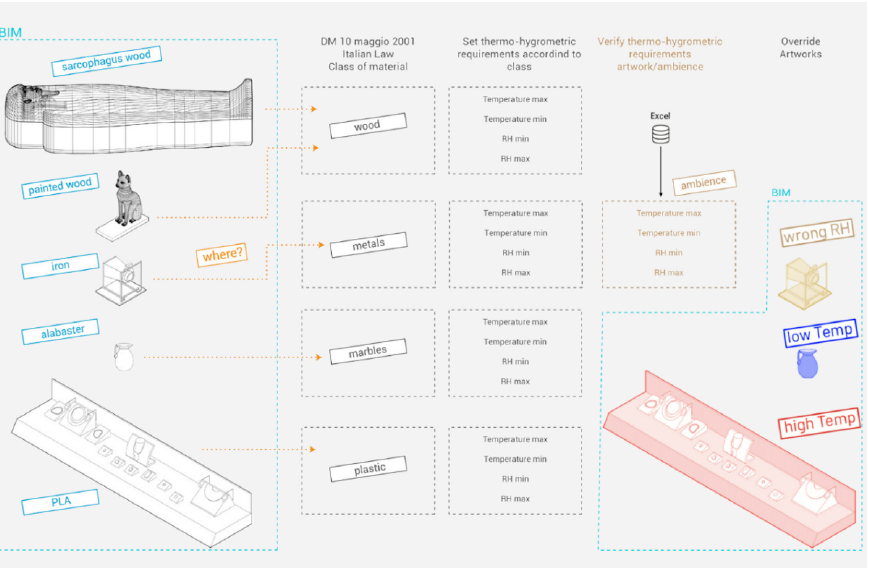
Figure 5. Scheme for verifying the environmental suitability between the artworks and the exhibition environment. Image by Arch. M. Cammarano.